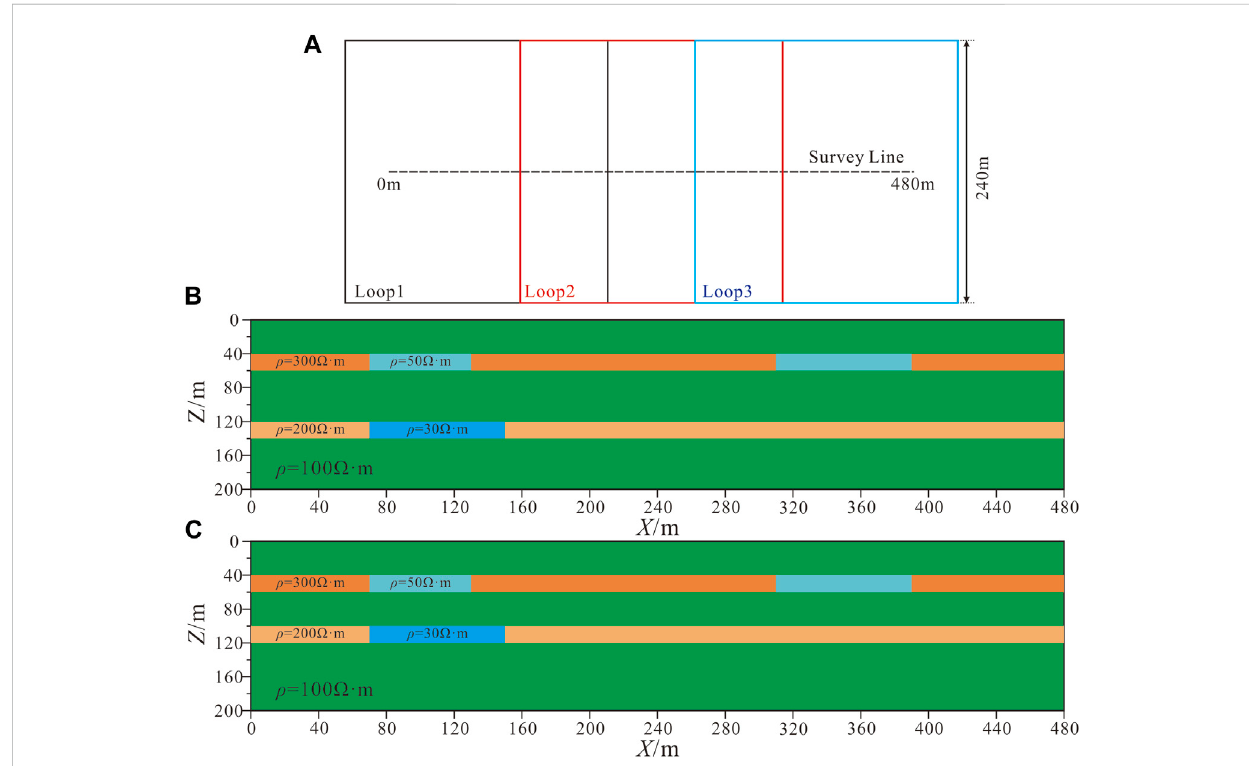
FIGURE 5 Synthetic multilayer models (various colors mean different resistivity in parts B and C). (A) : Receiving and transmitting schematic. (B) : Model 1 with large layer interval. (C) : Model 2 with small layer